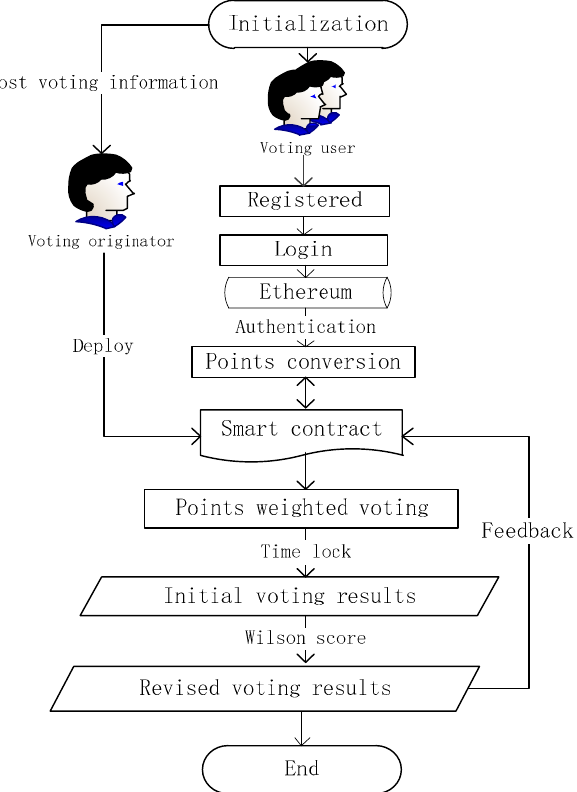
Figure 2. Voting flowchart with feedback mechanism.